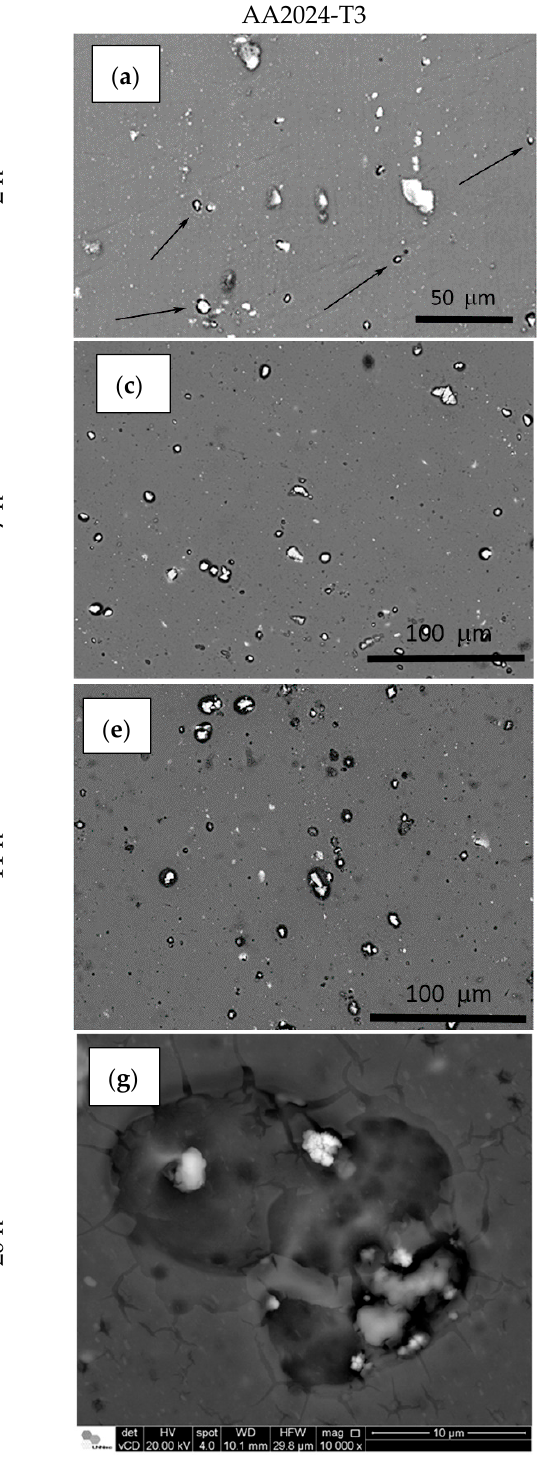
Figure 4. Microstructures of AA2024-T3 after ( a ) 2 h, ( c ) 7 h, ( e ) 11 h, and ( g ) 20 h. AA2524-T3 after ( b ) 2 h, ( d ) 7 h, ( f ) 11 h, and ( h ) 20 h of exposure to the 0.01 mol.L − 1 NaCl solution. SEM–BSE. The micrographs show the evolution of the localized corrosion at the interface IMC/matrix (indicated by arrows).